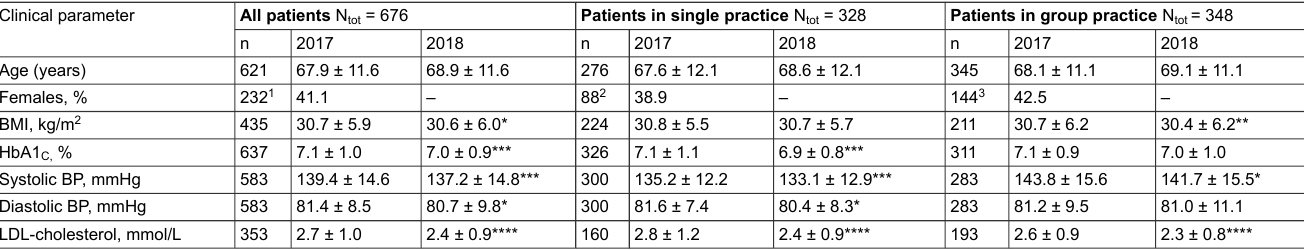
Table S2: Clinical variables limited to patients with data in both 2017 and 2018, further stratified by practice type. Clinical parameter All patients N tot = 676